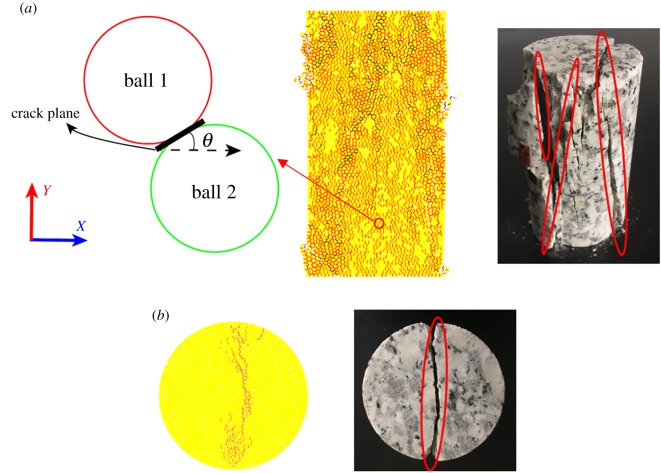
Comparison of failure modes obtained by laboratory tests and numerical simulations: (a) uniaxial compression test and (b) Brazilian test (the black line represents shear crack, while the red line is tensile crack; the yellow background is the rock sample).